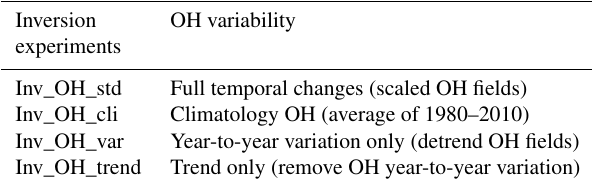
Table 1. Two-box model inversion